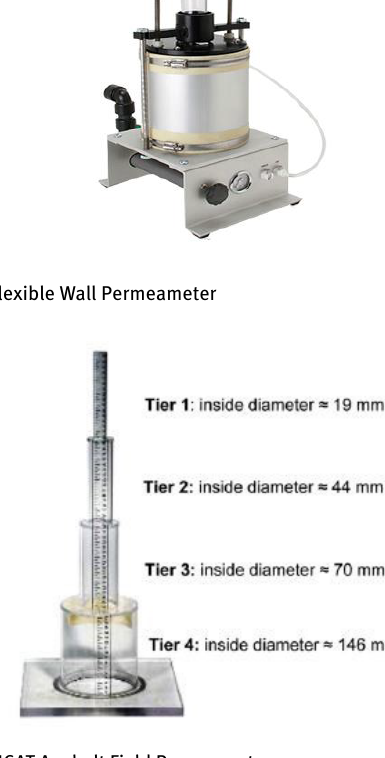
Figure 6: NCAT Asphalt Field Permeameter